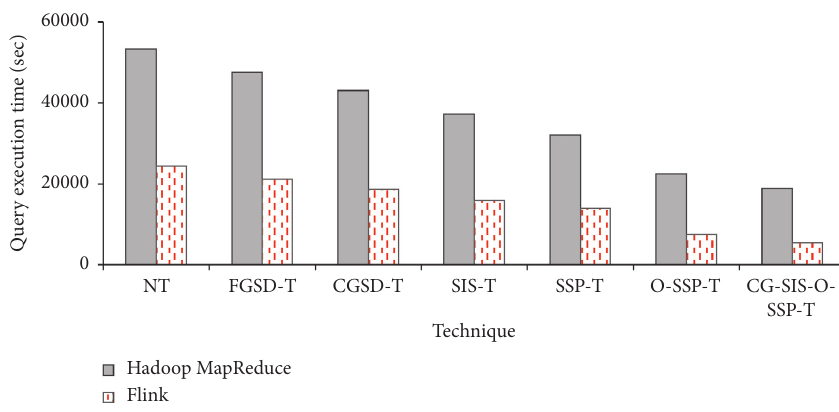
Figure 16: The query execution time of the J-MOTH multiway join optimizer